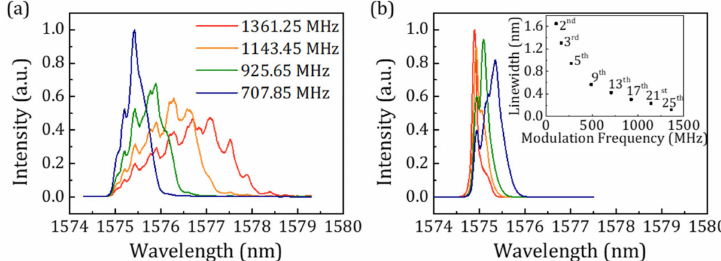
Figure 3. Comparison of the output spectra at the 13rd, 17th, 21st, and 25th orders of mode locking of ( a ) DGM and ( b ) XGM. Inset: Relationship between the linewidth and modulation frequency of XGM.